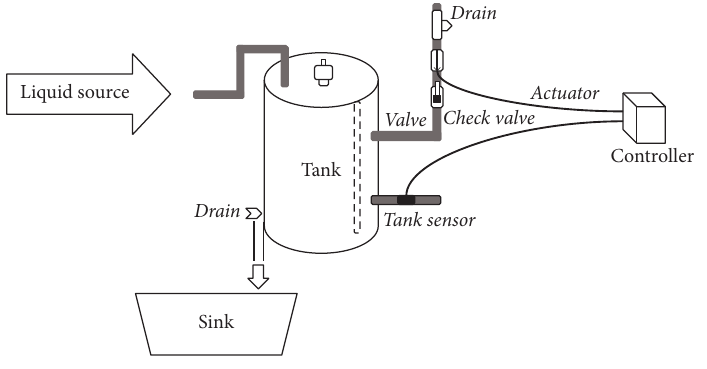
Figure 3: The reference Tank